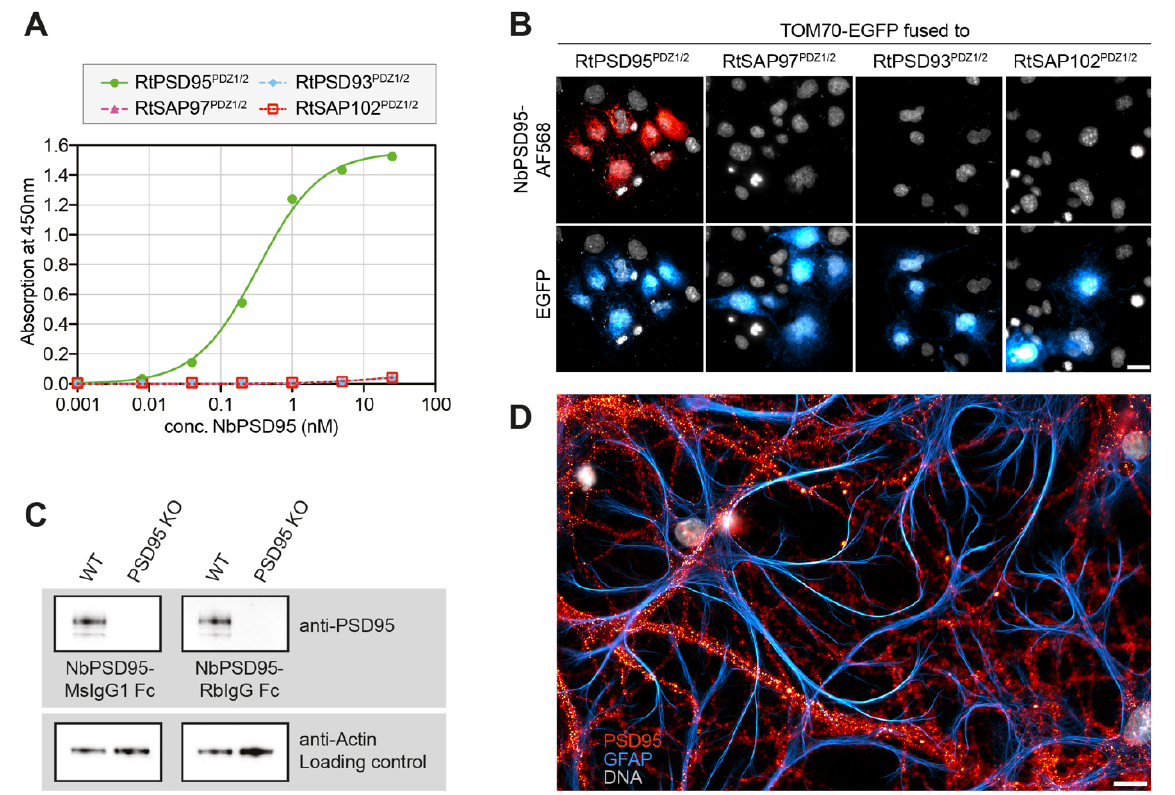
Figure 2. NbPSD95 specifically recognizes PSD95. ( A ) A dilution series of FLAG-tagged NbPSD95 was applied to ELISA plates coated with indicated PDZ domains fused to E. coli maltose-binding protein (MBP). The detection was performed with an HRP-coupled anti-FLAG antibody. A significant signal could only be obtained for PSD95 PDZ1/2 . ( B ) COS-7 cells were transfected with the indicated PDZ-domains fused to EGFP and a mitochondrial targeting sequence. After fixation with 4% PFA, the cells were stained with NbPSD95 coupled to AZDye568 (structurally identical to AlexaFluor568). The co-localization of NbPSD95 with GFP required the presence of PSD95 PDZ1/2 . Scale bar: 20 µm. ( C ) Total brain lysates from a wild-type (WT) mouse or a PSD95 knock-out mouse (PSD95 KO) were analyzed by Western blot using r-hcAb comprising NbPSD95 and a Fc domain from either mouse IgG1 (MsIgG1 Fc; left) or rabbit IgG (RbIgG Fc; right). Actin served as a loading control. Both r-hcAbs readily detected PSD95 in the WT lysate, while no signal was obtained using the PSD95 KO lysate, indicating that the r-hcAbs exclusively recognize PSD95. ( D ) PFA-fixed hippocampal primary neuronal cultures from rats were stained with NbPSD95 coupled to AZDye568 (false color representation in red). Counterstaining was performed with an anti-GFAP nanobody (FluoTag-X2 anti-GFAP Atto488, false color representation in cyan). NbPSD95 produced the typical punctate staining on neuronal structures. Scale bar: 20 µm.